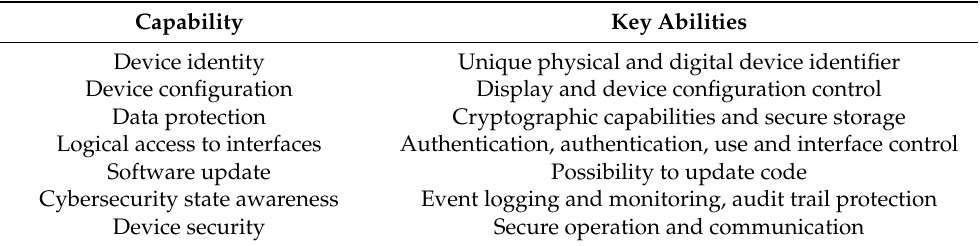
Table 2. Device cybersecurity capabilities. NIST-IR 8259D.